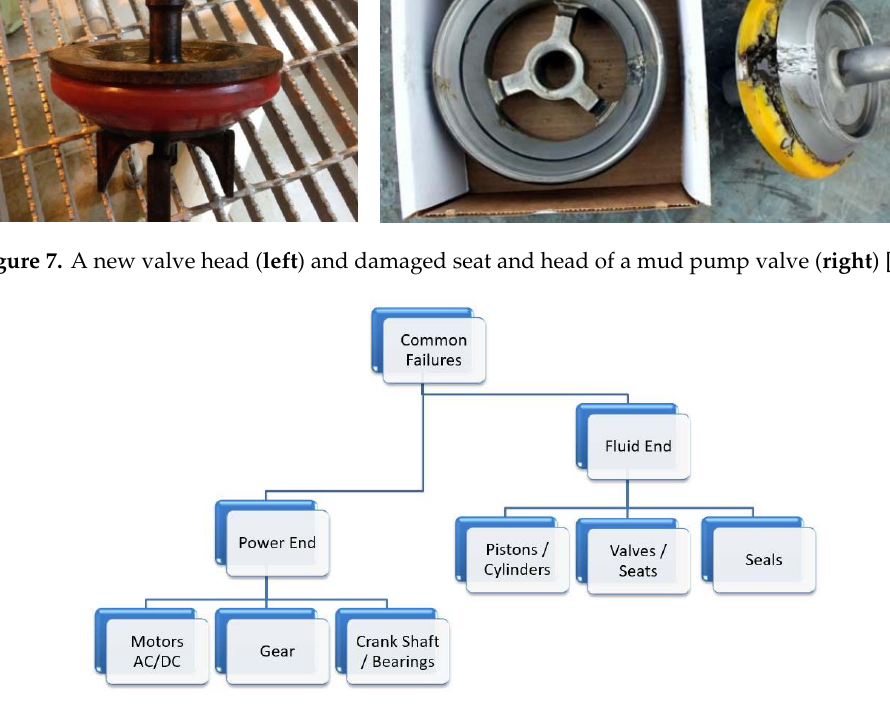
Figure 8. A fault tree for mud pumps.